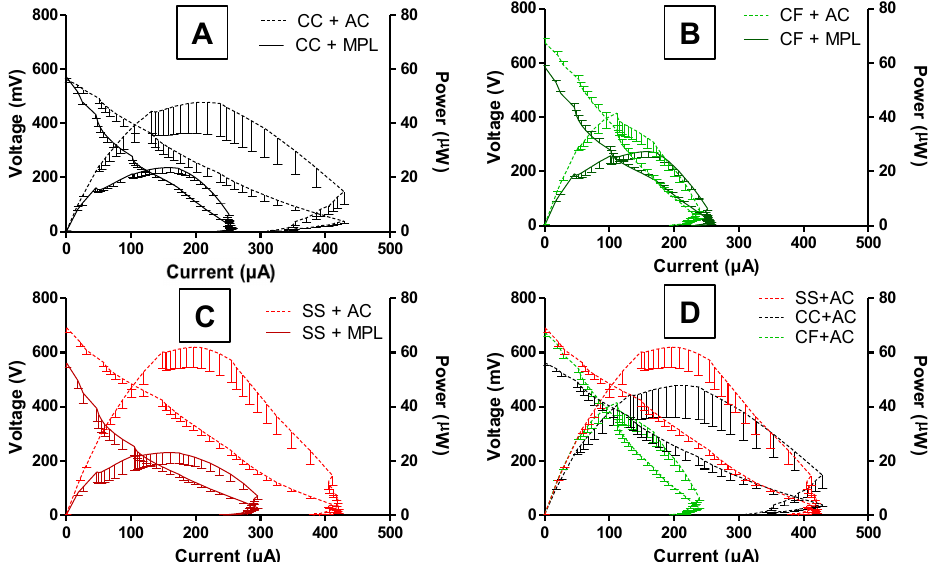
Figure 6. Comparison of the polarization curves of the MFCs (microbial fuel cells) with CB (straight line) and AC (dotted line) on the different substratum materials: ( A ) black CC; ( B ) green CF; and ( C ) red SS; and comparison of the MFCs’ performance using AC on different substratum materials ( D ).